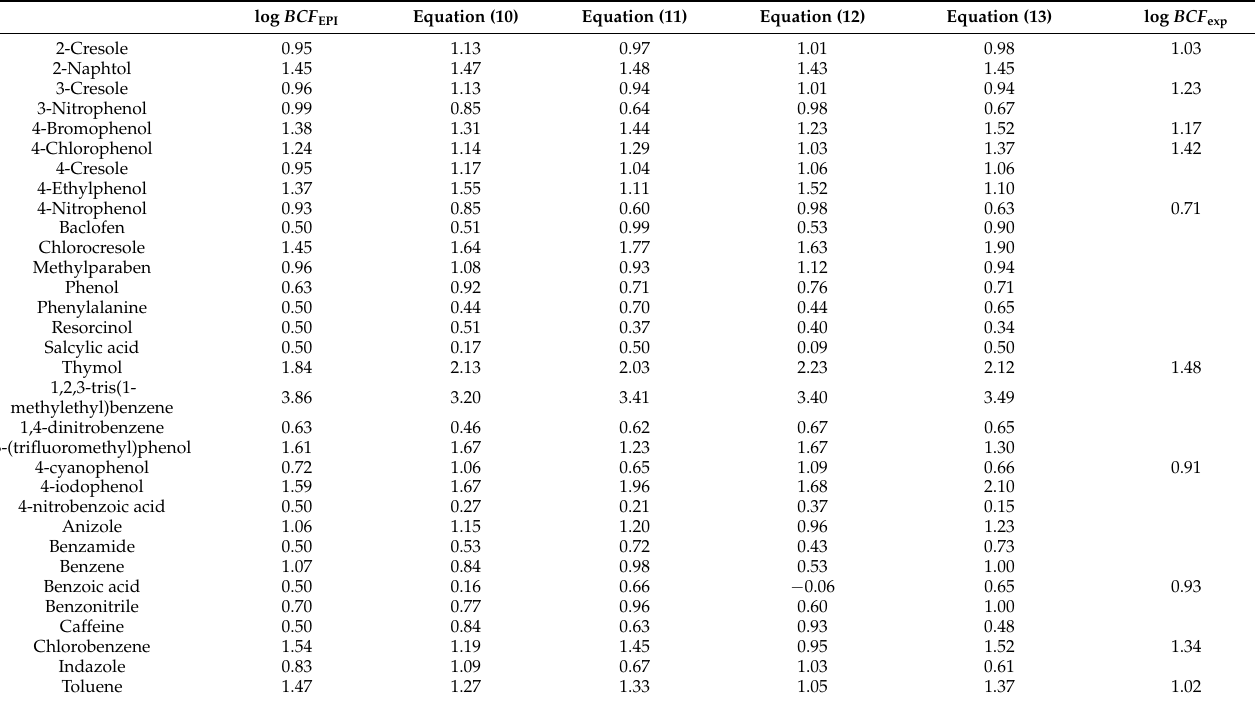
Table 3. Reference, predicted, and experimental values of log BCF